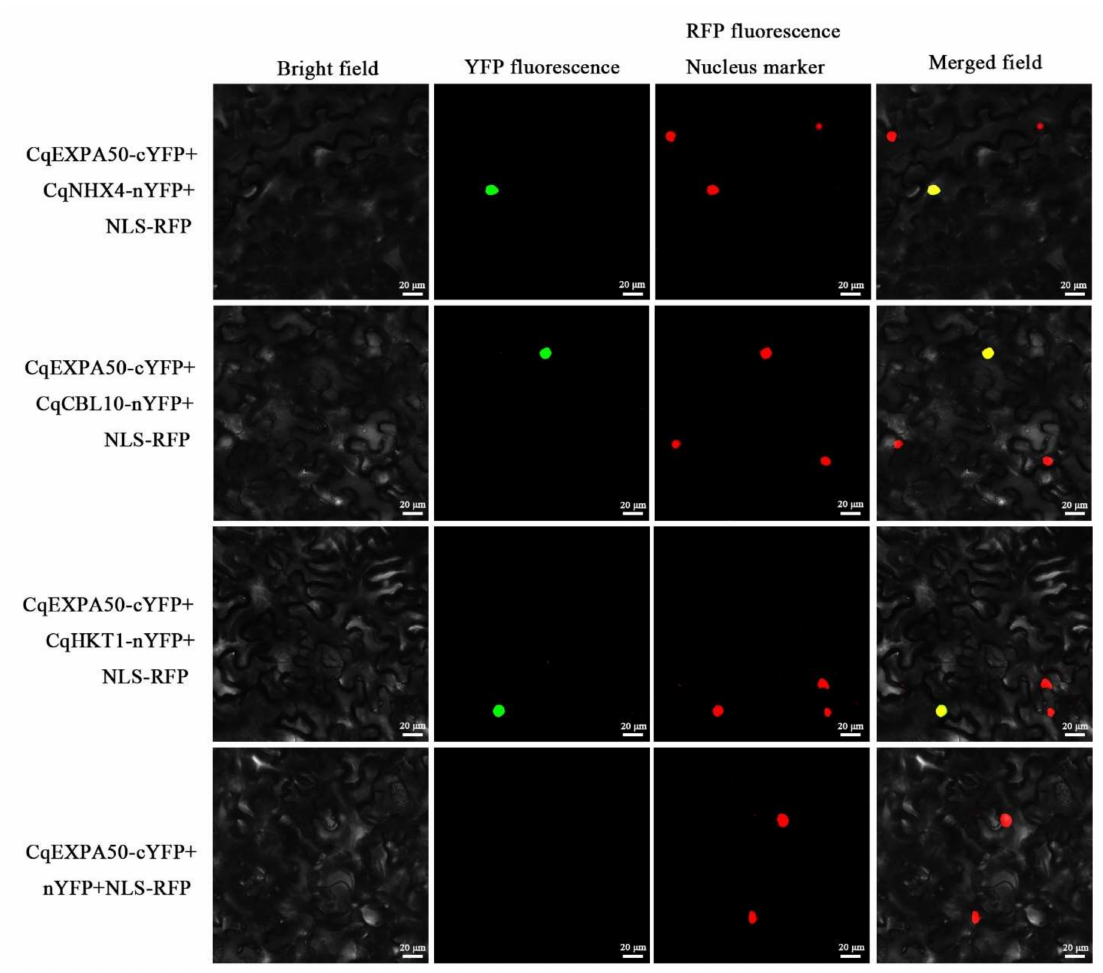
Figure 7. Interactions between CqEXPA50 andCqNHX4, CqCBL10 and CqHKT1. CqEXPA50 interact with CqNHX4, CqCBL10 and CqHKT1 in N. benthamiana leaves. CqEXPA50 was fused with the C-terminal fragment (YC) of yellow fluorescence protein (YFP) to form CqEXPA50- YC . CqNHX4, CqCBL10 and CqHKT1 were fused with N-terminal fragment of YFP (YN) to form CqNHX4- YN , CqCBL10- YN and CqHKT1- YN . Green indicates a positive interaction signal. No signal was observed from negative controls. Red represents the nuclear localization